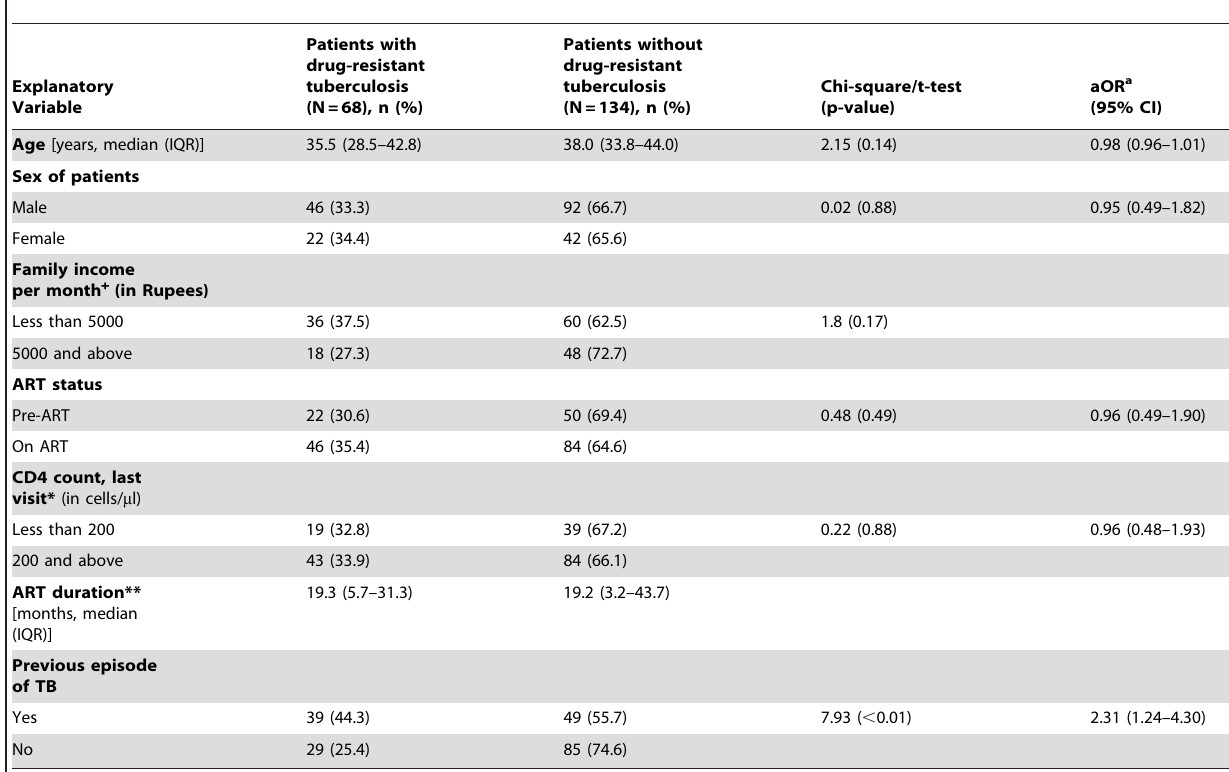
Table 4. Demographic and clinical factors associated with drug-resistant tuberculosis in HIV-infected tuberculosis patients, Mumbai,